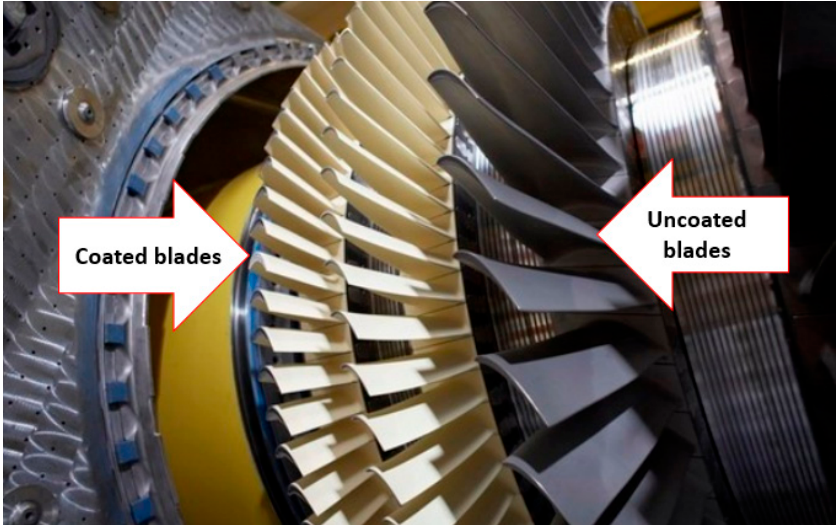
Figure 17. Coated and uncoated compressor blades [129].